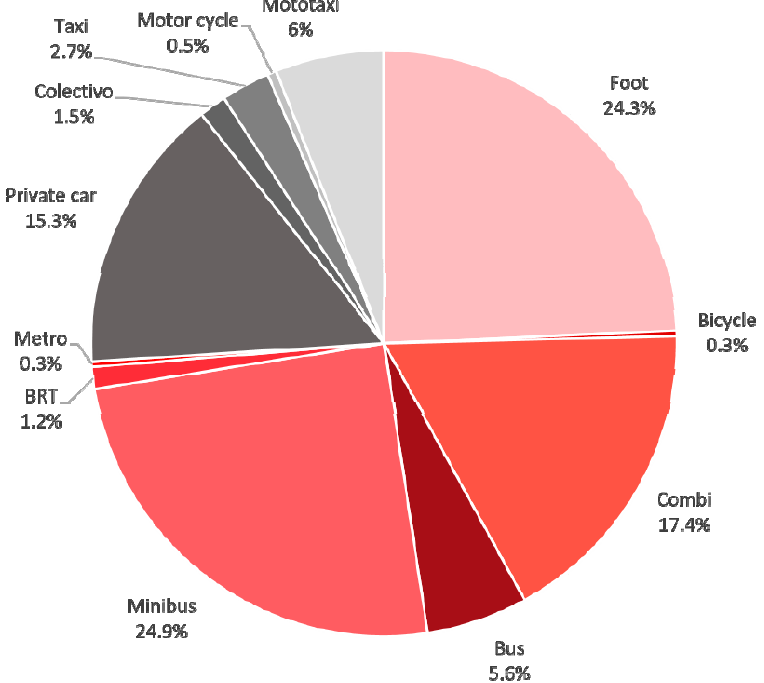
Figure 14. Percentage of daily trips by each transport mode in Metropolitan Lima, 2012. Source: Reference [39]. Graph by authors.